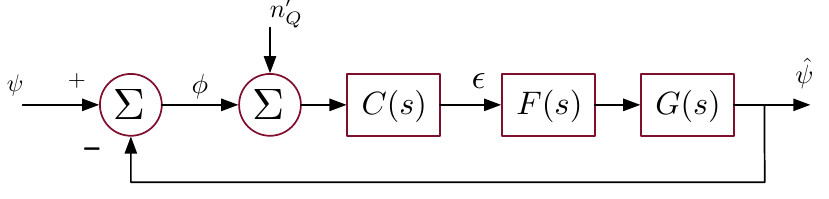
Figure 2. Augmented PLL linear